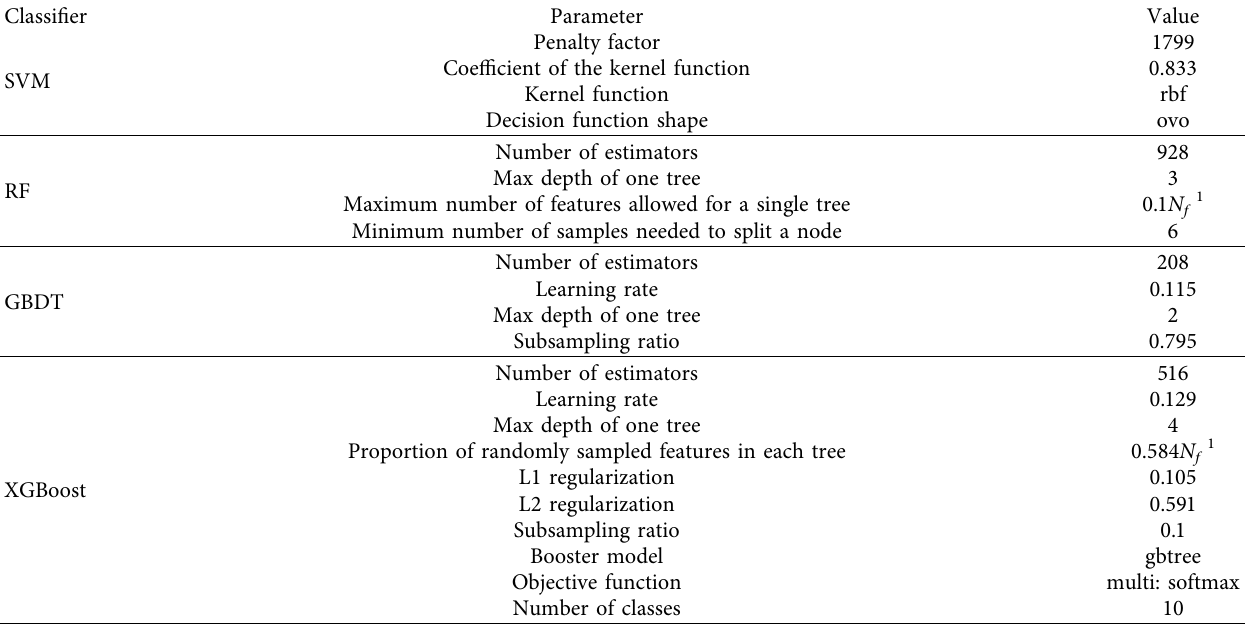
Figure 12: Comparison of diagnostic results with or without feature selection. (a) Model training time and the number of features used for classification. (b) Test set accuracy. Table 6: The main hyperparameters of different classifiers optimized by BO